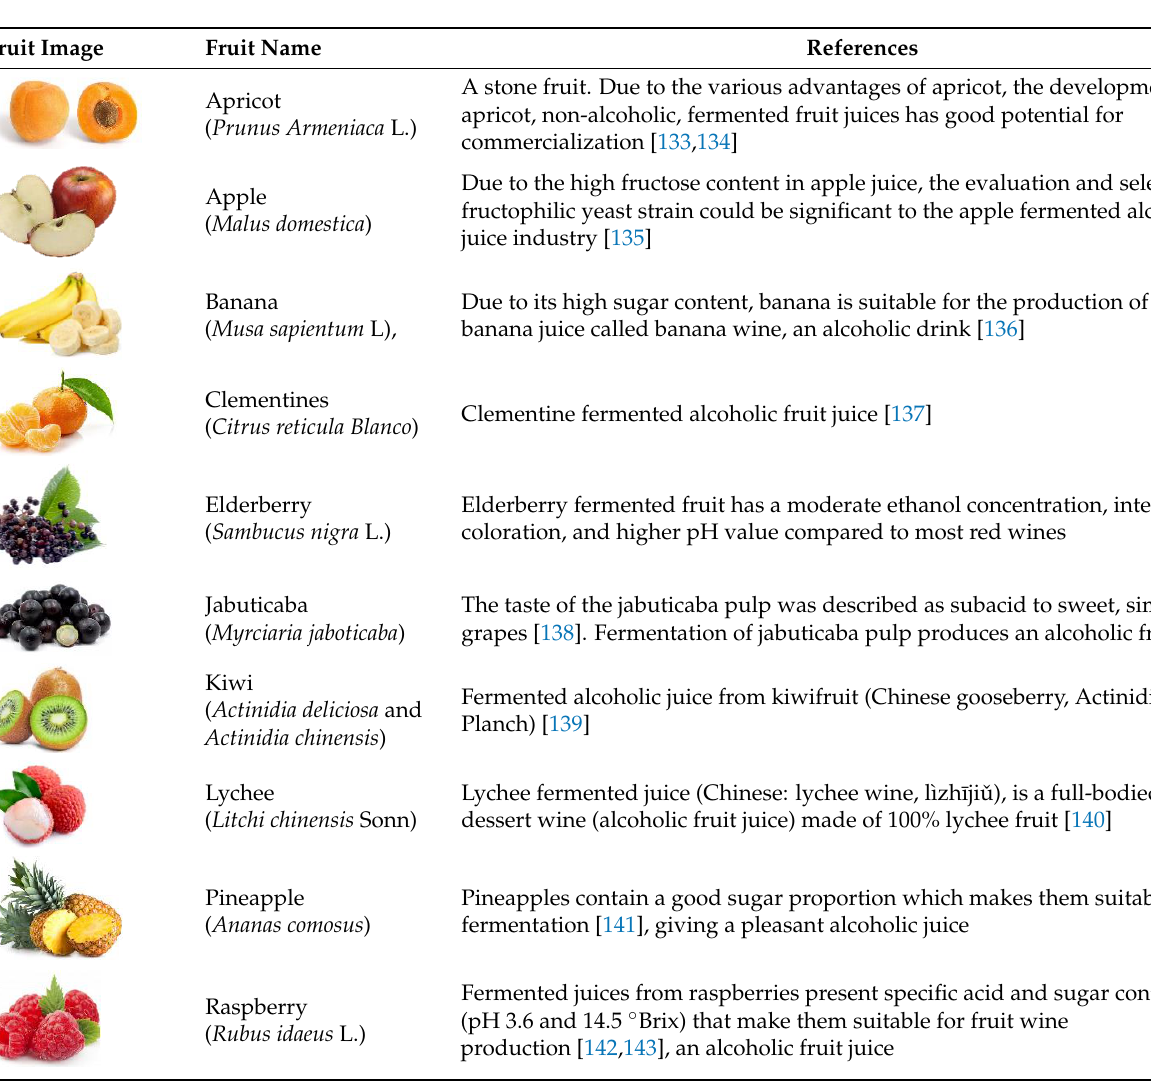
Table 3. Examples of some fermented fruit juices. The first published works in which they were mentioned are also referenced.